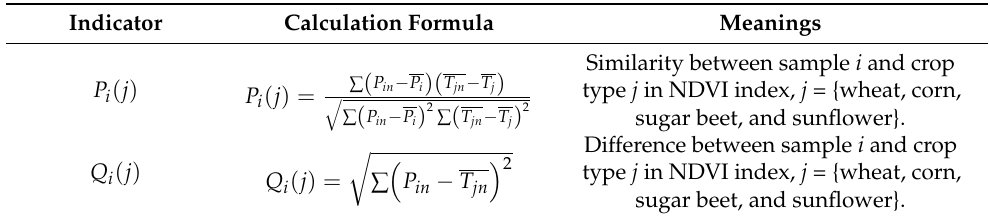
Table 1. Spectral indexes and interpretation.